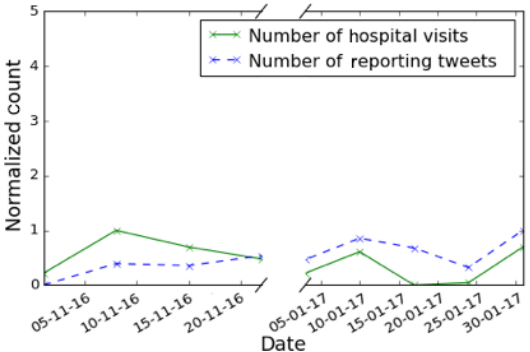
Fig. 3 Count of English tweets (classified as self) versus count of actual hospital visits.